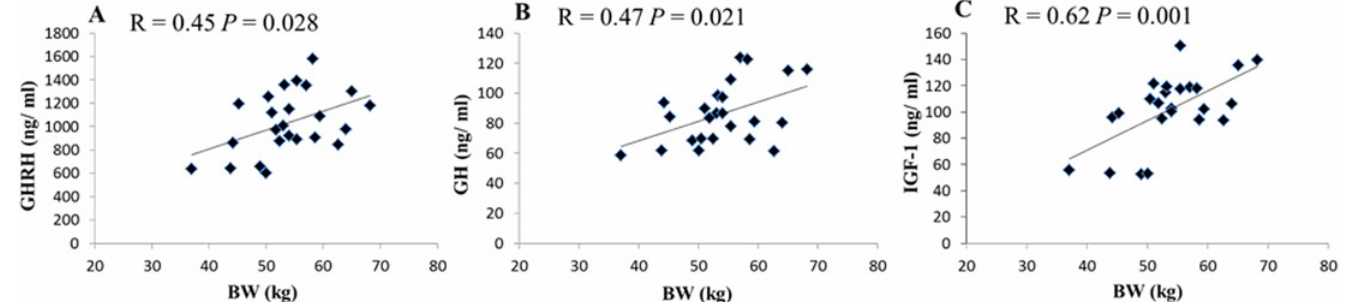
Fig 1. Relationship between body weight and somatotropic axis hormone level of yaks in groups I and II (n = 24) A is the relationship between the body weight and serum GHRH levels; B is the relationship between the body weight and serum GH levels; C is the relationship between the body weight and serum IGF-1 levels; P -values of less than 0.05 indicated significant correlation.